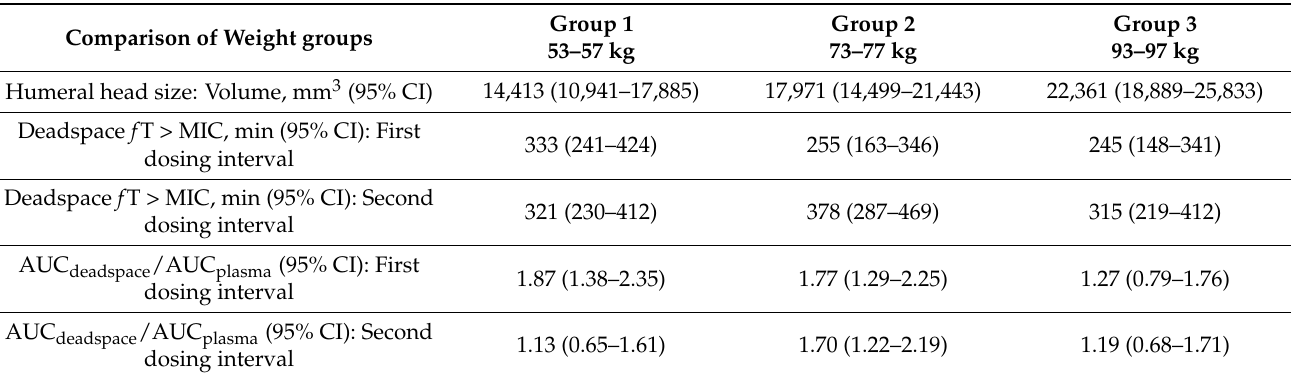
Table 1. Comparison of weight groups regarding humeral head size, deadspace f T > MIC and AUC deadspace /AUC plasma .